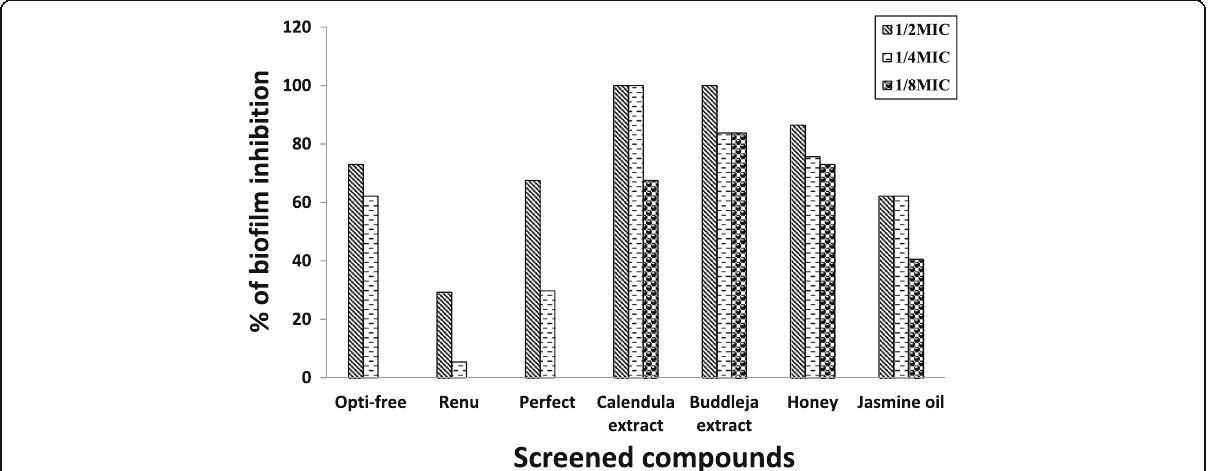
Fig. 1 Percentage of biofilm inhibition by screened CL-care solutions and natural